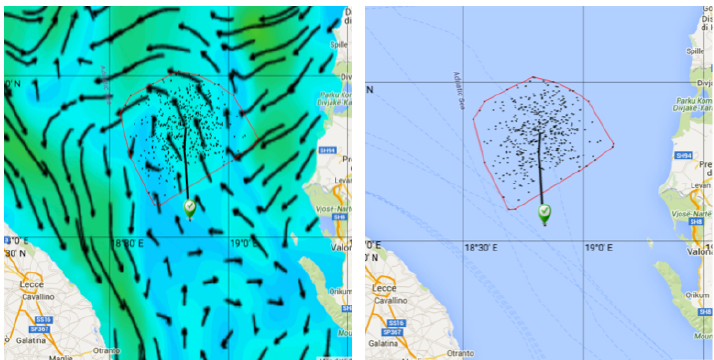
Figure 7. Display of the simulation results with environmental fields (left panel) and without environmental fields (right panel).